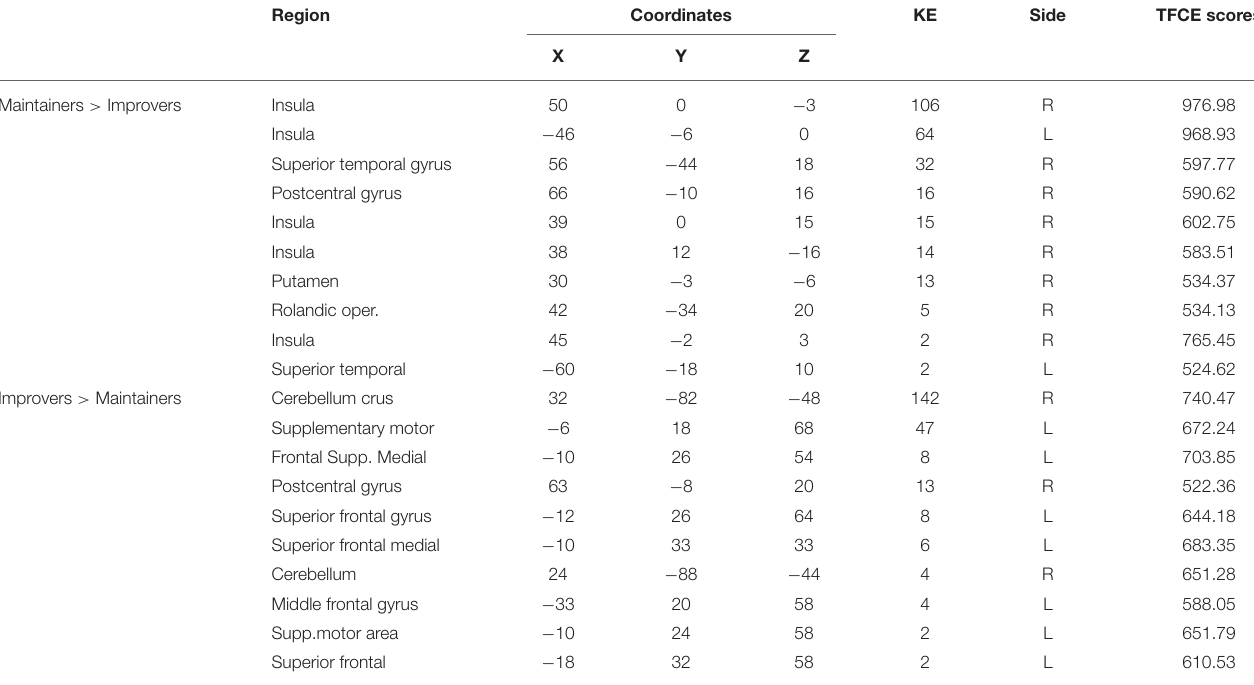
TABLE 2 | Seed based PCC (-7,-52,26) rsFC in the two ROP groups. Region Coordinates KE Side TFCE